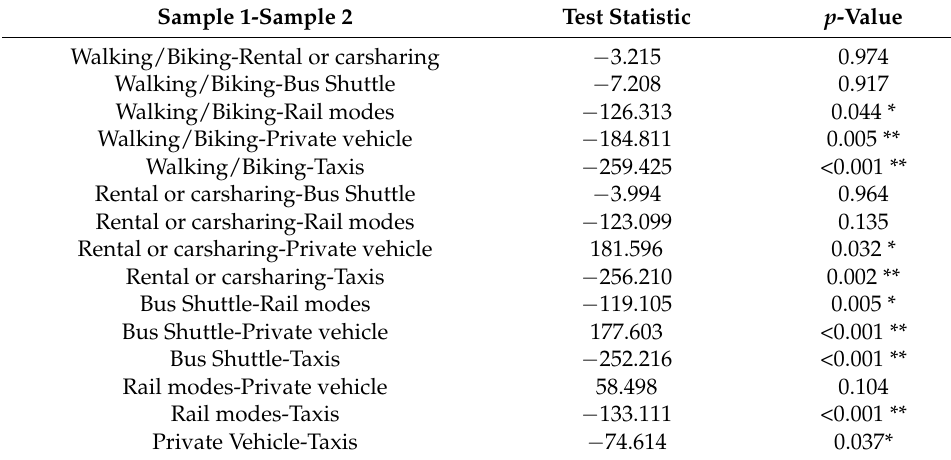
Figure 4. Boxplot of annual household incomes per each replaced mobility mode. Figure 4 indicates that the medians of annual household incomes of people who replaced walking/biking, rental cars/carsharing, and bus shuttles are less than people who replaced taxis, private cars, and rail modes by ridesourcing. Table 3 indicates the Kruskal- Wallis test results for pairwise comparison in the distributions of household income among replaced modes by ridesourcing. Table 3. Kruskal-Wallis test for pairwise comparison of household incomes among mobility